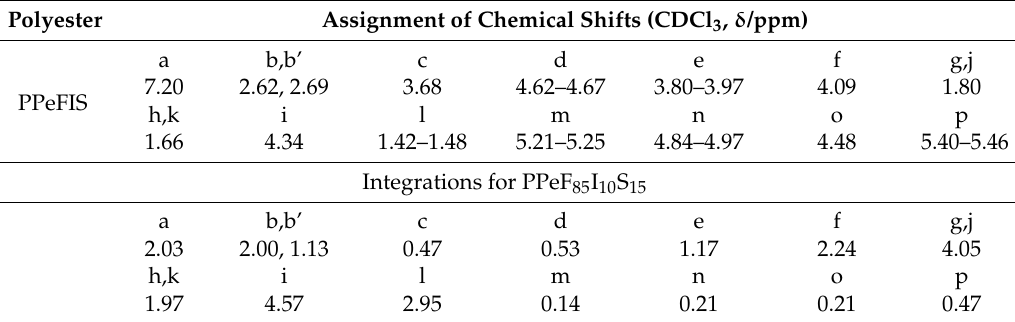
Table 3. Assignment of chemical shifts of PPeFIS and integrations for PPeF 85 I 10 S 15. Polyester Assignment of Chemical Shifts (CDCl 3 , δ /ppm)